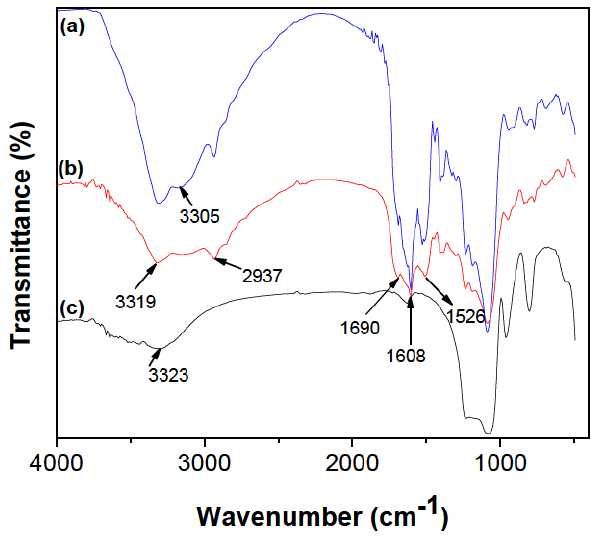
Figure 3: FTIR spectra of (a) MNPSiO 2 -FA/Cis-Pt, (b) MNPSiO 2 -FA, and (c) MNPSiO 2 samples.